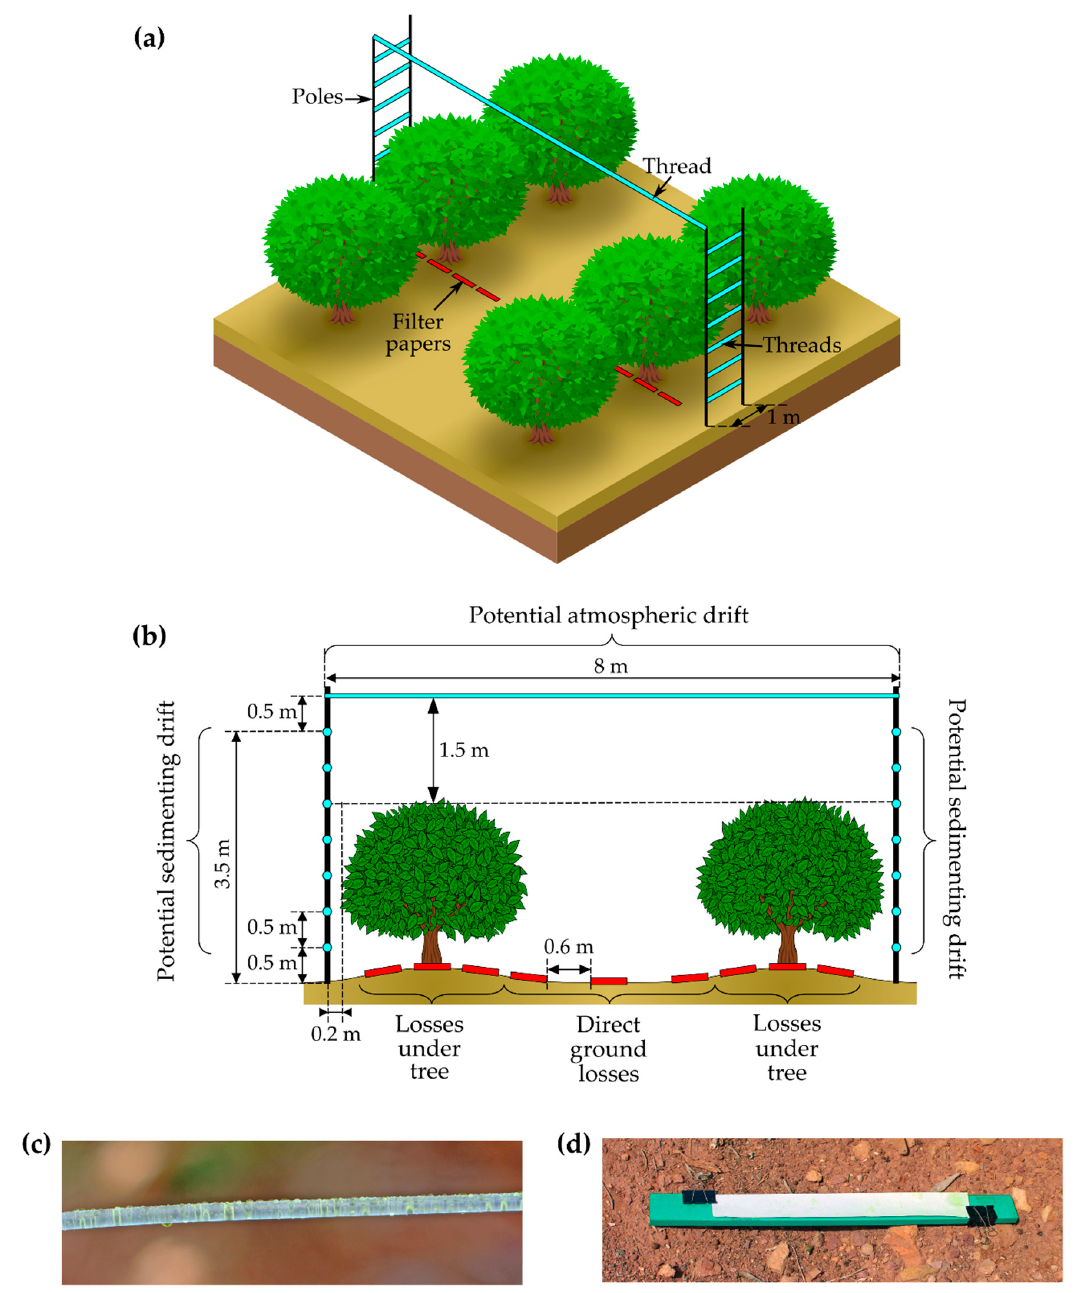
Figure 7. Collectors of off-target losses: ( a ) perspective and ( b ) side view across the row of the young plot with the structure provided by the collectors to estimate the potential drift and losses to the ground. The potential-drift-collecting threads are shown in light blue, and the ground-loss-collecting filter papers are shown in red. Collectors used: ( c ) nylon thread to estimate the potential drift and ( d ) filter paper to estimate ground losses.